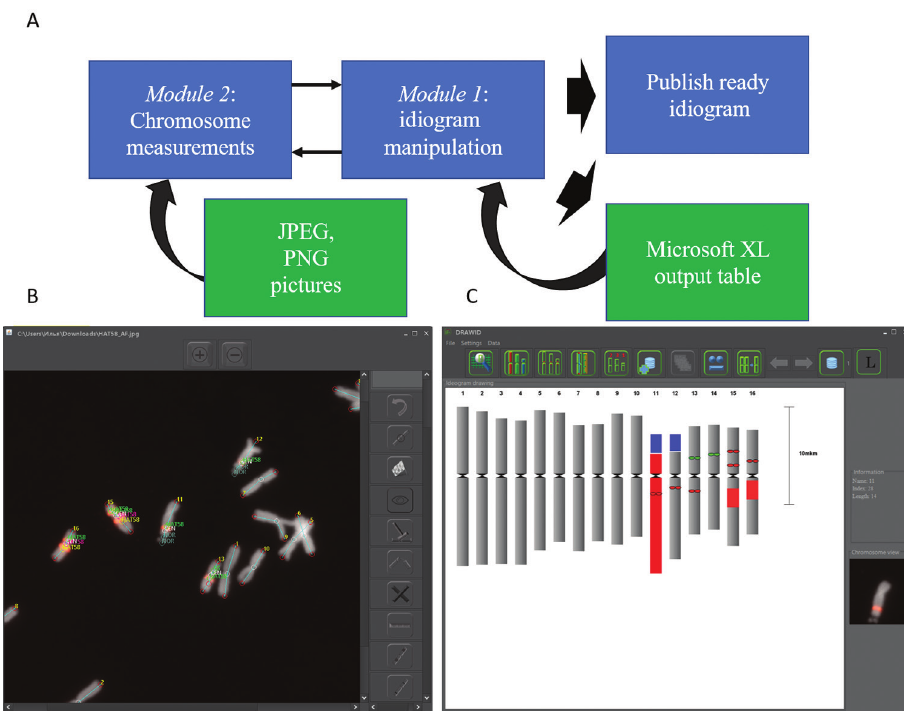
Figure 1. Structure ( A ) and main windows of DRAWID ( B, C ). B Interface of chromosome measurement window, containing useful tools for chromosome and FISH/GISH signal measurements. The photograph in this panel shows the result of a FISH experiment on chromosomes of Allium fistulosum with biotin-labeled 5S rDNA and HAT58 repeat (Kirov et al. 2017). Lines and signatures show the path of chromosome and signal measuring C Interface for idiogram manipulation. This panel shows the idiogram of A. fistulosum con- structed based on chromosome measurements and FISH (5S rDNA and HAT58 tandem repeat) signal posi- tions in panel B Buttons at the top of the panel are used for chromosome and centromere color changing, display legend, chromosome order correction and idiogram storage manipulation. When a chromosome in the constructed idiogram is selected (entire chromosome 11 highlighted in red the image of the selected chro- mosome along with the parameters of its measurement appear on the screen (on the right of the panel C